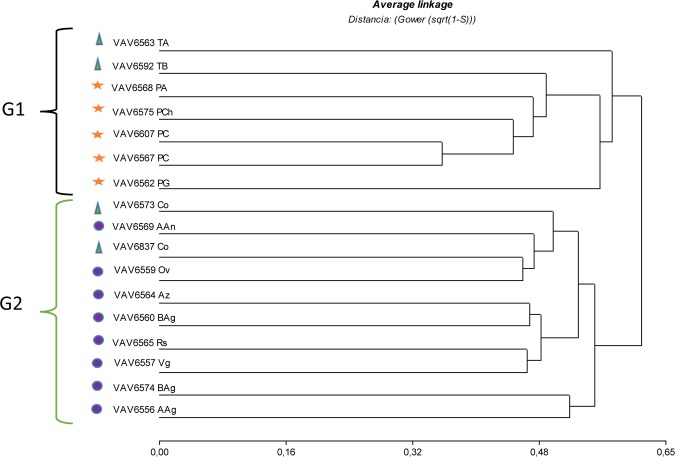
Relationships among Guaranís maize populations (UPGMA).Shapes represented populations with different type of grain. Ref. Yellow stars: Popcorn maize populations. Blue circles: Floury populations. Green triangle: Floury grains with corneal periphery (F-PC) populations. Yellow stars: Popcorn populations. PCh: Pororó Chico. PG: Pororó Grande. PA: Pipoca Amarillo. PC: Pipoca Colorado. TA: Tupí Amarillo. TB: Tupí Blanco. Az: Azul. Rs: Rosado. Vg: Variegado. AAn: Amarillo. Ancho. AAg: Amarillo Angosto. Co: Colorado. Ov: Overo. Ban: Blanco Ancho. Bag: Blanco Angosto.